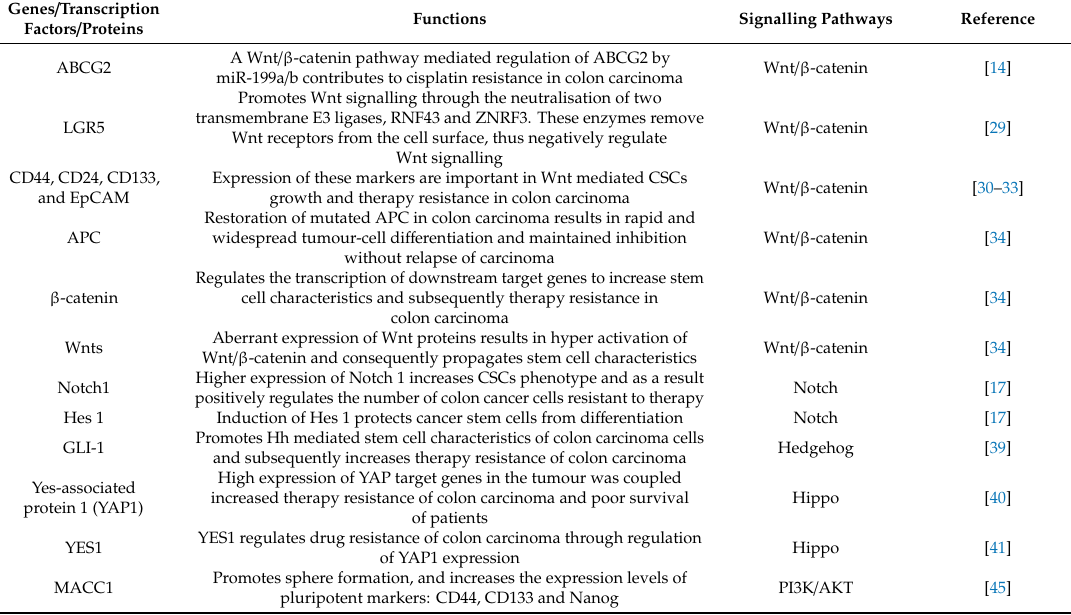
Table 1. Genes / Transcription factors / Proteins associated with signalling pathway mediated drug resistance in cancer stem cells in colon